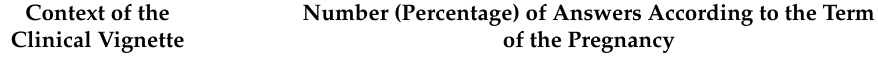
Table 2. Results of clinical scenarios of primary initial infections.